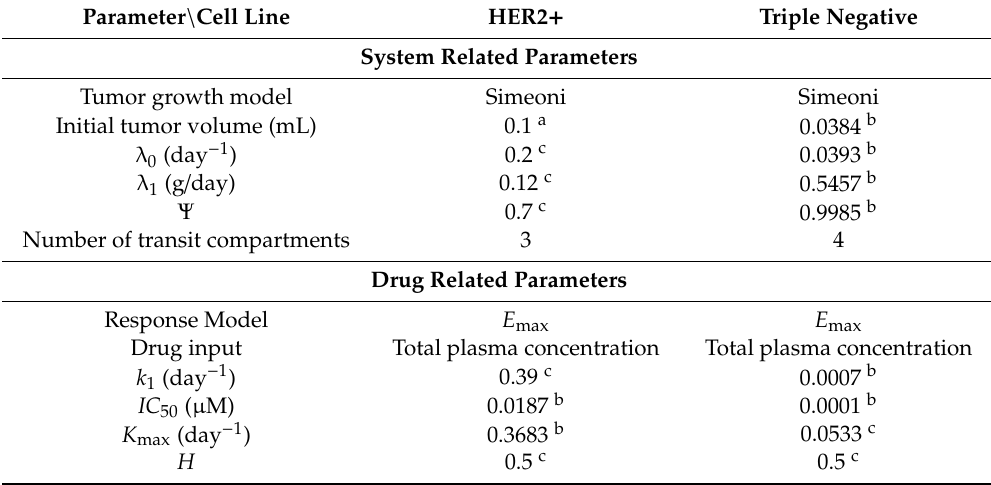
Table 2. Parameters of the tumor growth (unperturbed and perturbed)